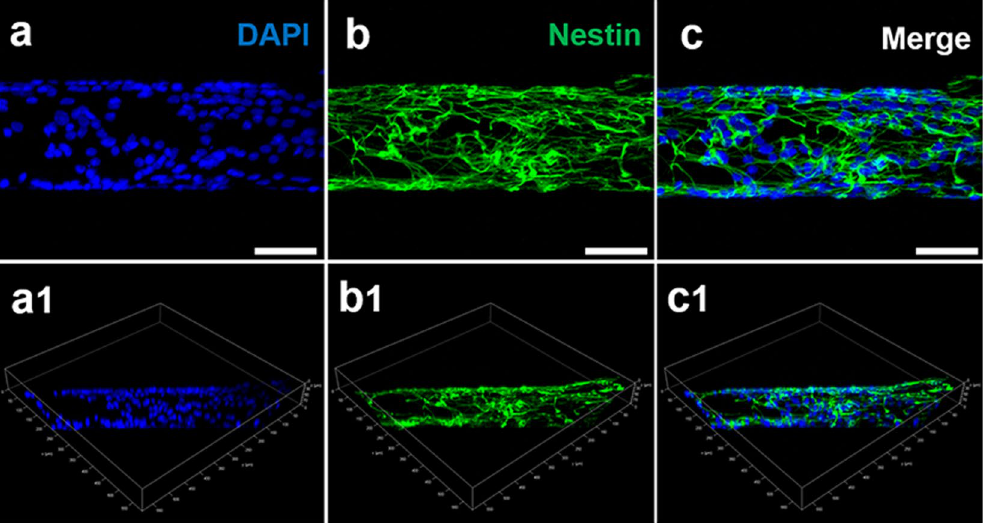
Figure 3. NSC adhesion on nanostructured rGO microfiber. 2D CLSM fluorescence micrographs of NSCs proliferated on the nanostructured rGO microfiber for 5 days; immunostaining makers were DAPI (blue) ( a ) for nuclei and Nestin (green) ( b ) for NSCs, and their images were merged ( c ). (Scale bar = 50 μ m) The 3D